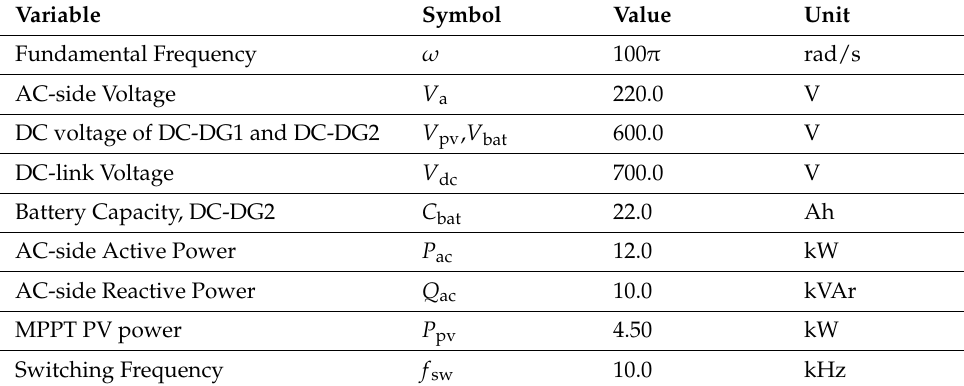
Table 2. Hybrid MG nominal values [19].